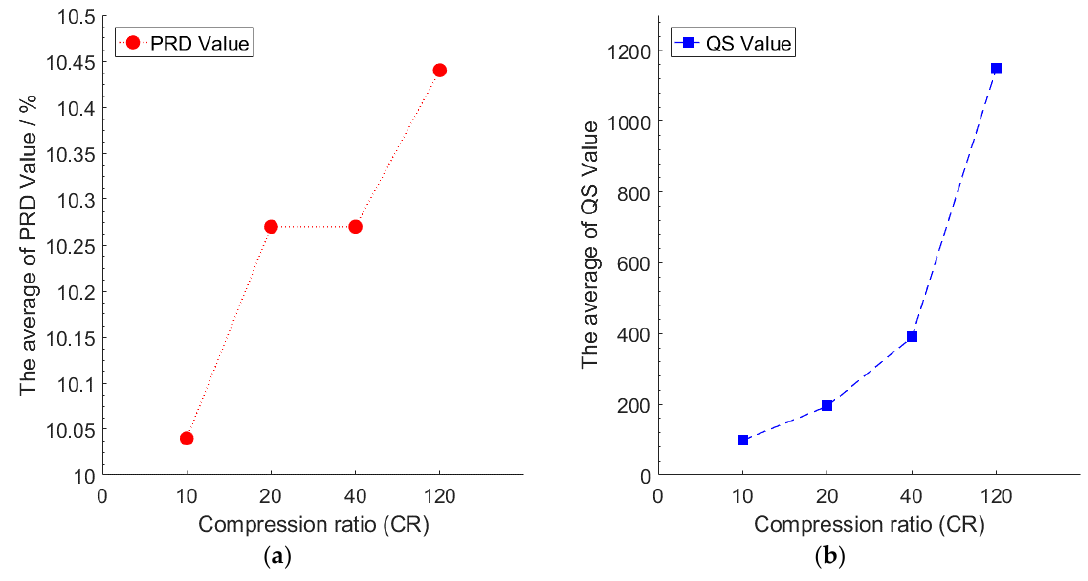
Figure 7. ( a ) The PRD value under different CRs , ( b ) The QS value under different CRs.